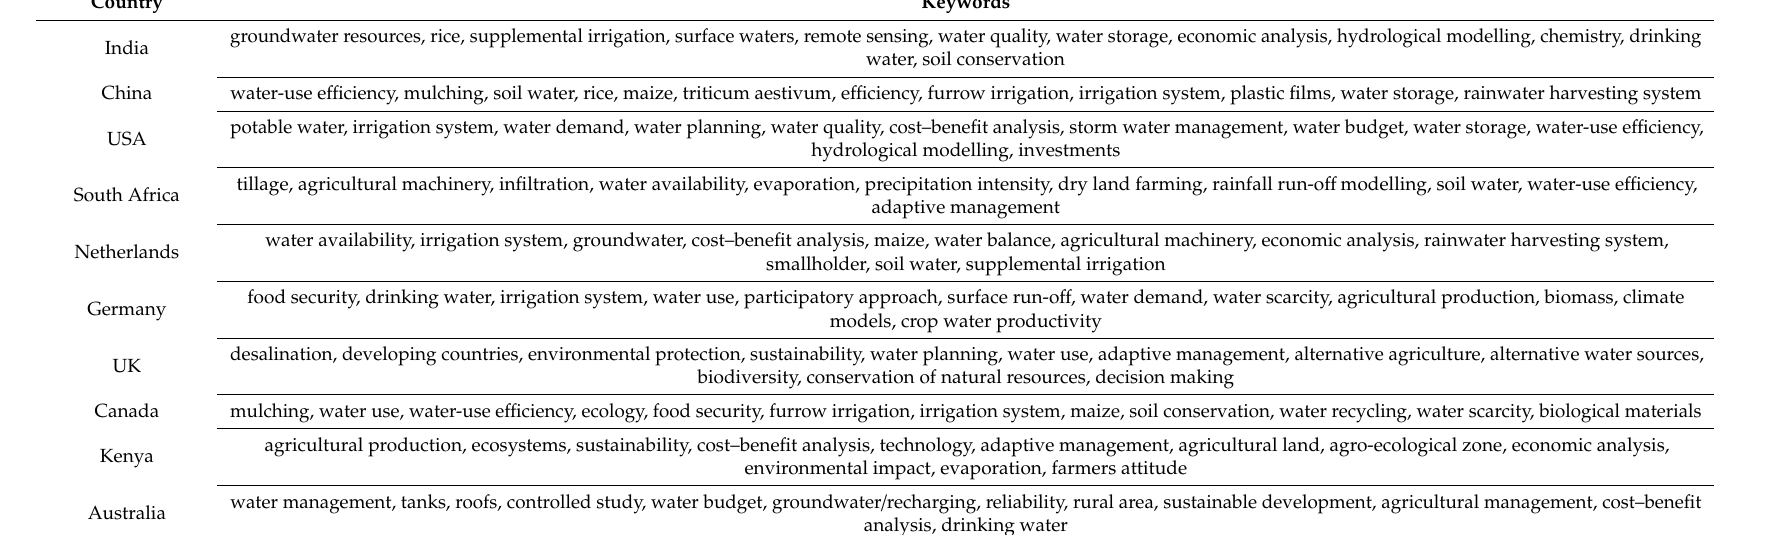
Table 5. Main keywords for the most active countries in RWHI